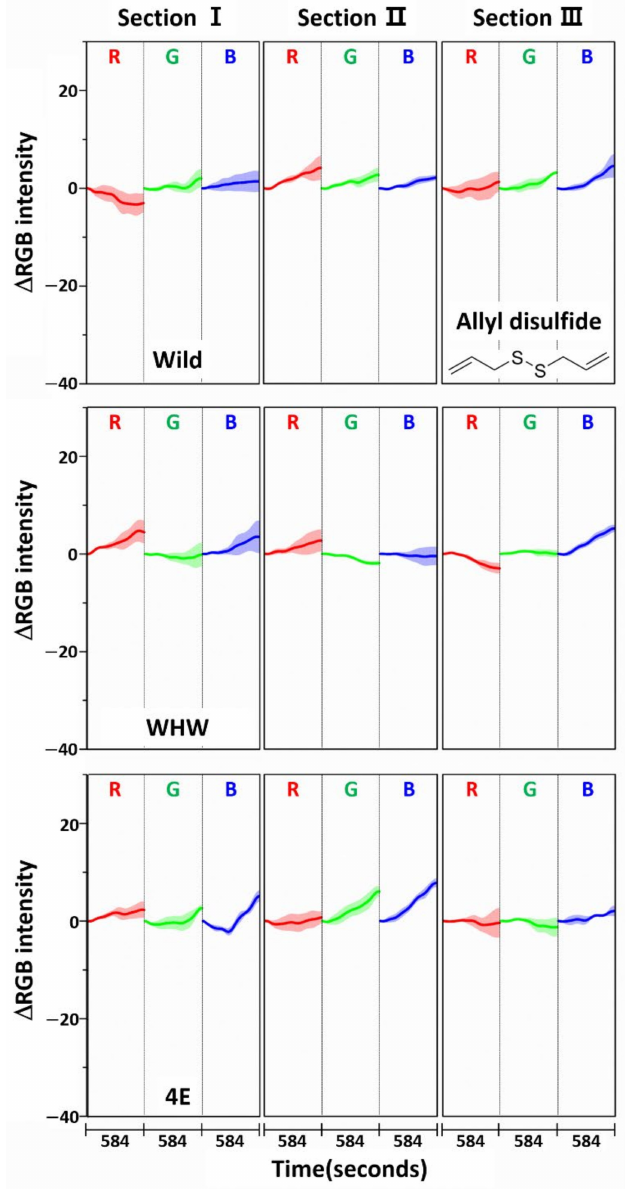
Figure 5. Average ∆ RGB intensity of allyl disulfide acquired using Wild, WHW, and 4E sensors. The molecular structure of allyl disulfide is also